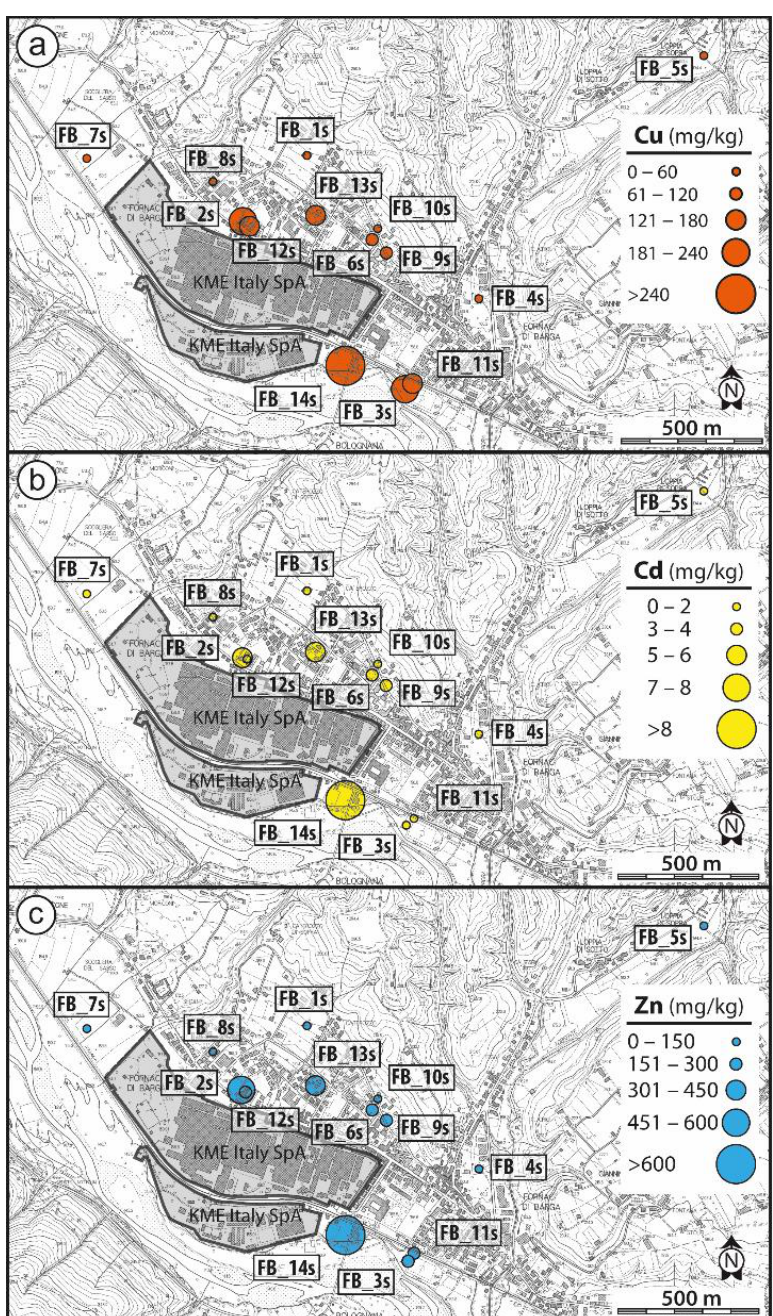
Figure 3. Copper ( a ), Zn ( b ), Cd ( c ) concentration in Fornaci di Barga soil. 4.2. Groundwater The physico-chemical parameters and major element chemistry measured on ground- water are given in Table 3; trace elements analyses are reported in Table 4. The major ions chemistry is graphically shown in the Piper diagram of Figure